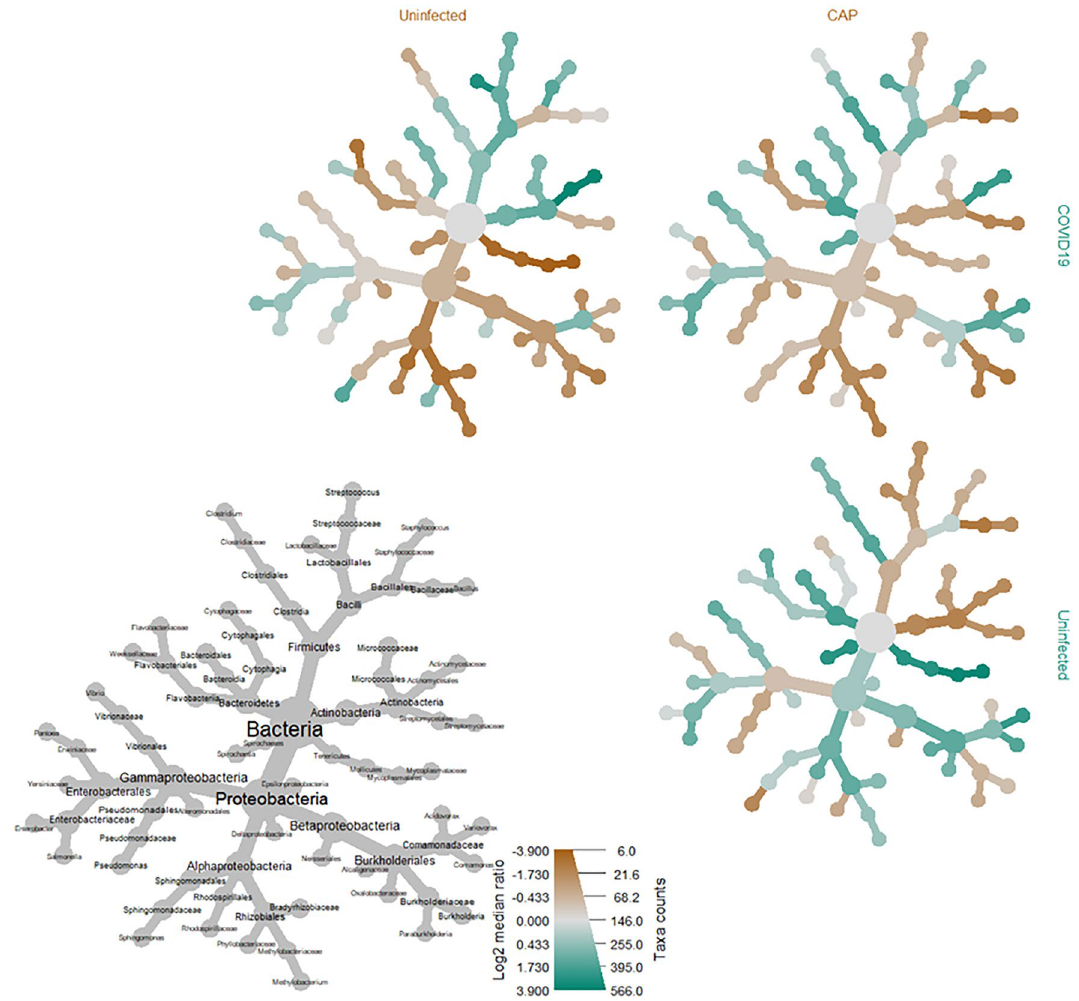
Figure 2. Heat tree matrix visualizing distinct COVID-19 vs. uninfected & community acquired viral pneumonia taxonomic profiles. This taxonomic heat tree data matrix visualization depicts the log2 median ratio differences across the three different cohorts. The tree depicted in grey in the lower left represents a taxonomic assignment key for all the other trees. Each of smaller trees represents a comparison between the different cohorts, as labelled in the columns and rows. The taxa colored brown are more abundant among the cohort labelled in the columns, whereas taxa colored green are more abundant in the cohort labelled in the rows. For example, there were significant increases (green) identified in log2 median ratio of several species belonging to the genus Sphingomonas when comparing the COVID-19 to the uninfected cohort (top left) and decreases (brown) when comparing the uninfected cohort to the community acquired pneumonia (CAP) cohort (bottom driven by an enrichment of SARS-CoV-2 proteins (Suppl. Tables 10, 12, 14). Mixed among proteins from other organisms, an enrichment of Variovorax proteins tagged with the terminal GO terms of pyrimidine-containing compound biosynthetic process [GO:0072528] (e.g., CTP synthase, putative sulfonate/nitrate transport system substrate-binding protein), organonitrogen compound catabolic process [GO:1901565] (e.g., histidine ammonia- lyase, aspartate/glutamate leucyltransferase), magnesium ion binding [GO:0000287] (e.g., proteins involved in the histidine biosynthesis pathway, such as phosphoribosyl-AMP cyclohydrolase), and DNA recombination [GO:0006310] (e.g., inclusive of possible Variovorax phage proteins—integrase family protein, putative trans- posase IS4 family, phage integrase family protein) appeared in the COVID-19 deceased patients. This enrichment of Variovorax proteins among samples from individuals who died of COVID-19 was consistent with the results from the taxonomic comparison analysis. Compared to the survived group, the taxonomic comparisons in the deceased group revealed a statistically significant (p < 0.0001, q < 0.001) increase of the family Comamonadaceae, belonging to the genus Variovorax , and decreases in the family Bacteriodales (Fig. 4, Table 6).